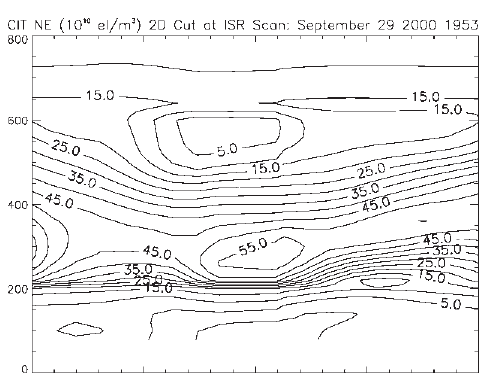
Fig. 8. Tomographic image reconstructed from satellite passes around 2000 UT, prior to the start of the in- coherent scatter radar